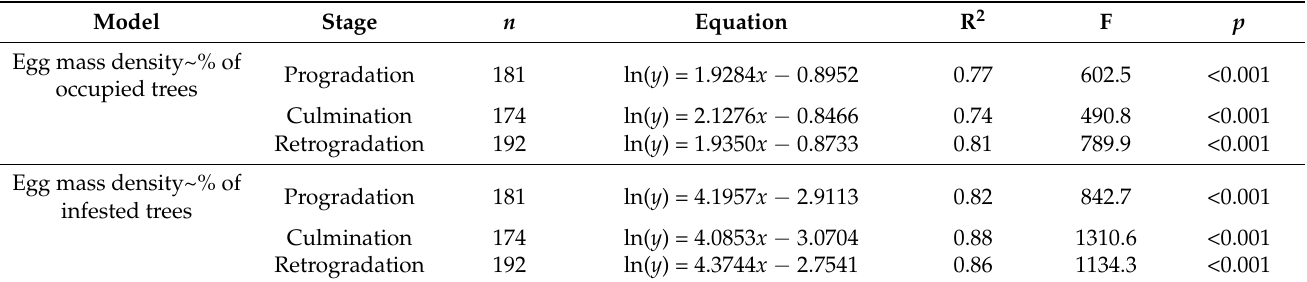
Figure 2. Validation of enumerative sampling plans to assess the infestation of Lymantria dispar on cork oak trees, based on Green’s plan showing actual precision levels ( A , B ) and sample sizes ( C , D ) calculated at a fixed level of 0.25 ( A , C ) and 0.10 ( B , D ). Dotted lines indicate the desired precision levels of 0.10 ( A ) and 0.20 ( B ). Table 3. Results of linear regression analyses aimed at exploring the relationship between the number of Lymantria dispar egg masses ( y ) and the percentage of occupied (i.e., trees with 1 or more egg masses) or infested (i.e., trees with 3 or more egg masses) trees ( x ). Linear regressions were fitted separately for each phase of gypsy moth population